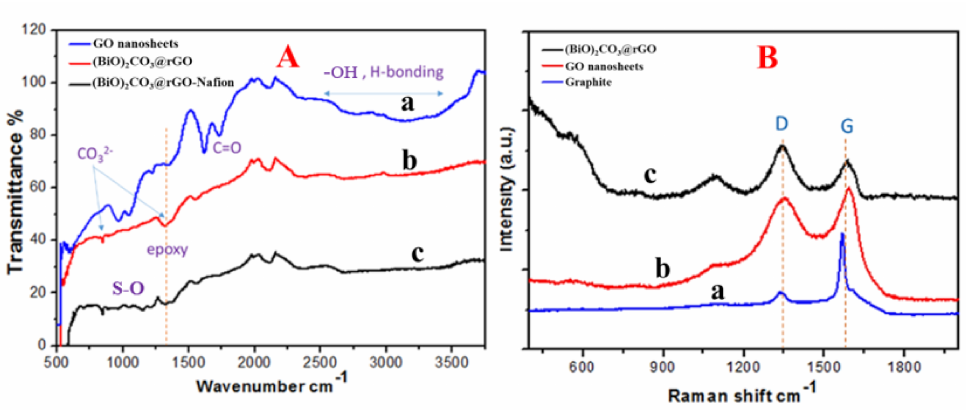
Figure 2. ( A ) Fourier transform infrared spectroscopy (FTIR) spectra of graphene oxide (GO) nanosheets ( a ), (BiO) 2 CO 3 -rGO nanocomposite ( b ) and (BiO) 2 CO 3 -rGO-Nafion nanocomposite ( c ); ( B ) Raman spectra recorded at the 514 nm laser beam of graphite ( a ), GO nanosheets ( b ), and (BiO) 2 CO 3 -rGO nanocomposite ( c